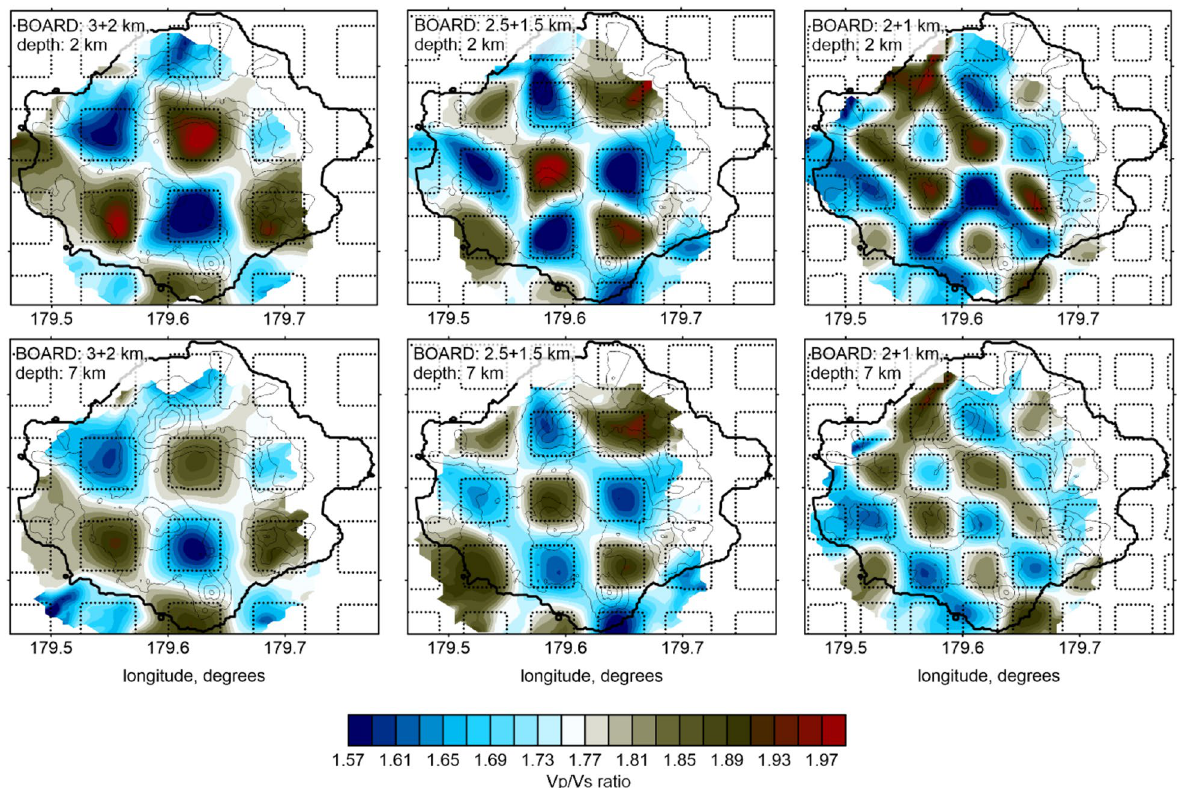
Figure 3. Resulting distributions of the Vp / Vs ratio after the recovery of three horizontal checkerboard tests. The sizes of the synthetic anomalies and intervals are indicated in the left corner of each map. The locations of the synthetic anomalies are indicated by the dotted lines. The topography is contoured at 200 m intervals. The figure was generated using the software Surfer (version 13, http:// www. golde nsofw are. com/ produ cts/